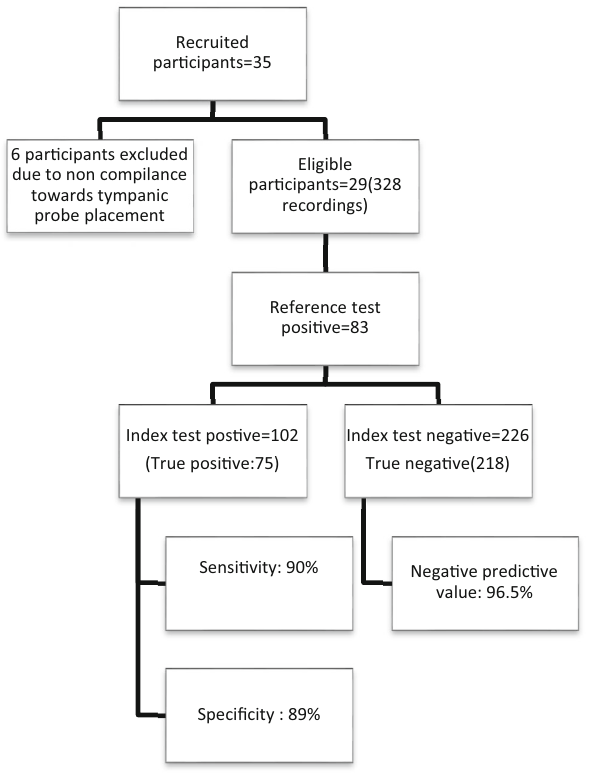
Figure 1. Summary of the study.